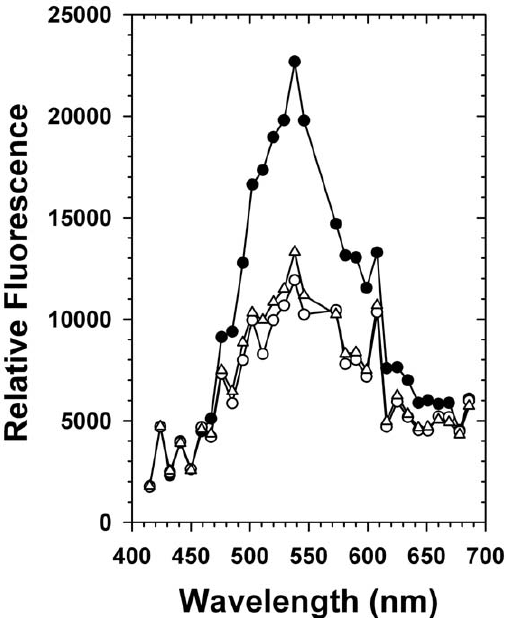
Figure 4. Fluorescence emission spectra. The fluorophore properties of PFA-fixed L. tarentolae promastigotes (Fig. 1) were analyzed in situ by laser scanning microscopy using a Zeiss LSM780 microscope and the software ZEN 2010. Emission spectra of the cytosol (open circles), mitochondria (closed circles), and whole cells (open triangles) are shown. A 458 nm laser served as a light